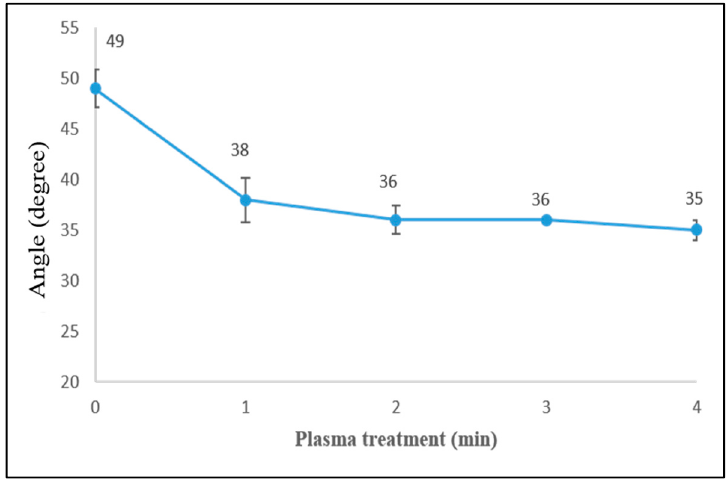
Figure 7. Angle values of single ramie fibers (plasma treated at various times) and phenolic resin.